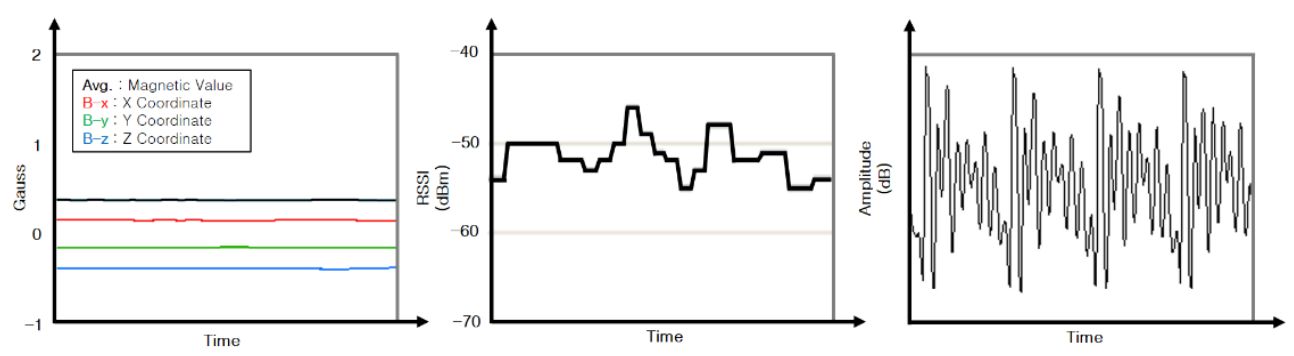
Figure 1. Measurement of geomagnetic field ( left ), wireless LAN ( middle ), and sound waves ( right ) according to time.